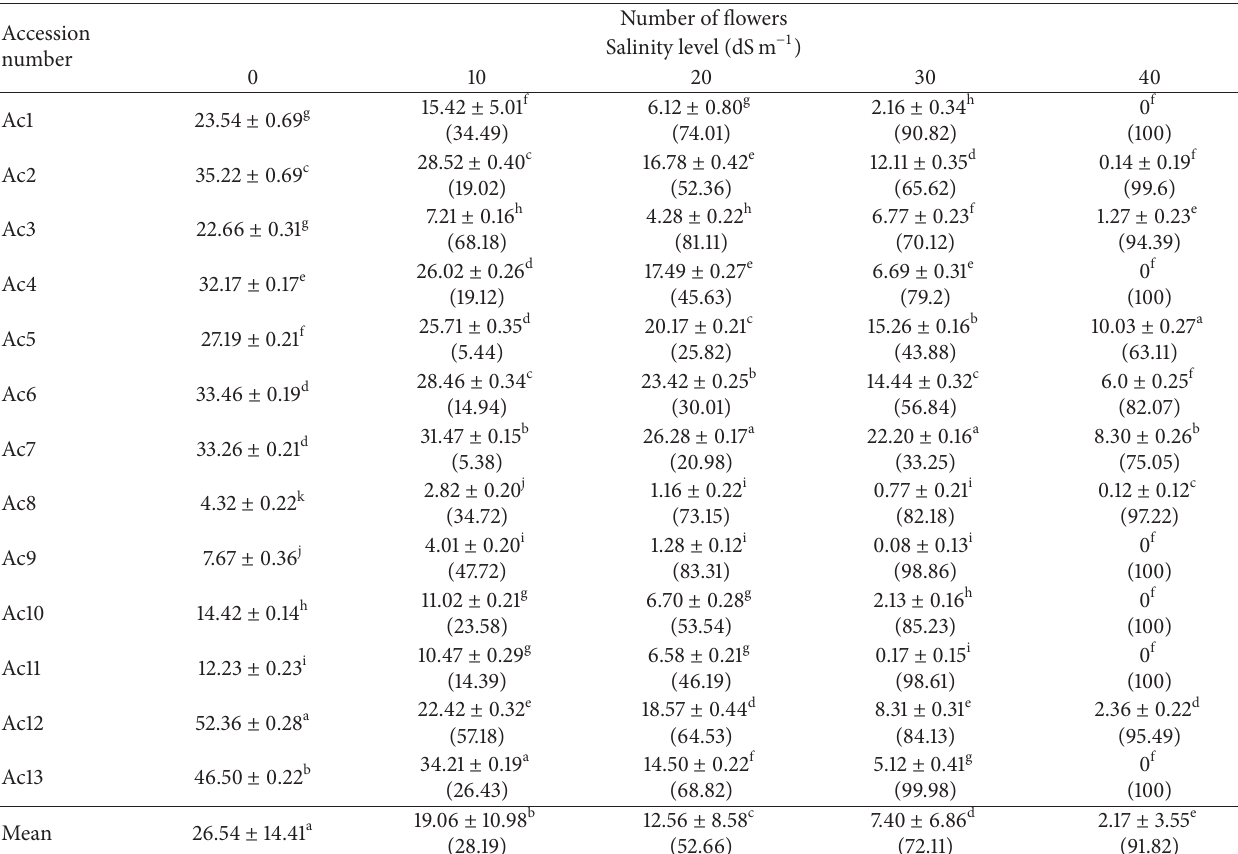
Table 8: Effect of salinity on number of flowers of 13 salt treated purslane